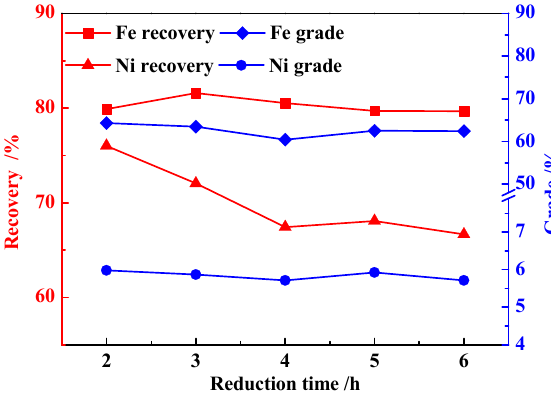
Figure 7. Effects of reduction time on grades and recoveries of Ni and Fe.